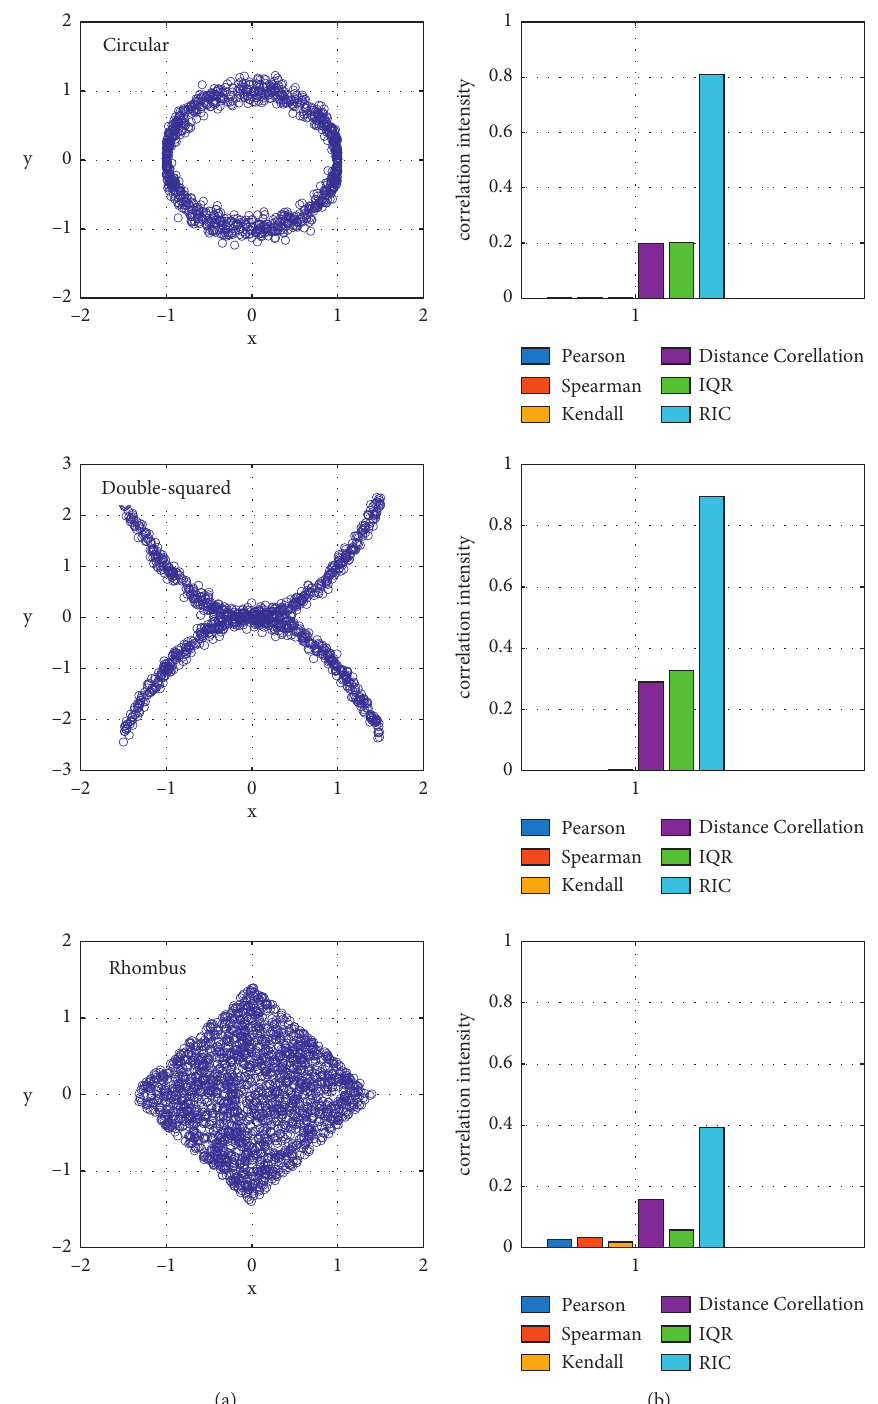
Figure 4: Main examples of the main functional dependencies investigated. (a) Examples of synthetic data. (b) The numerical values of the